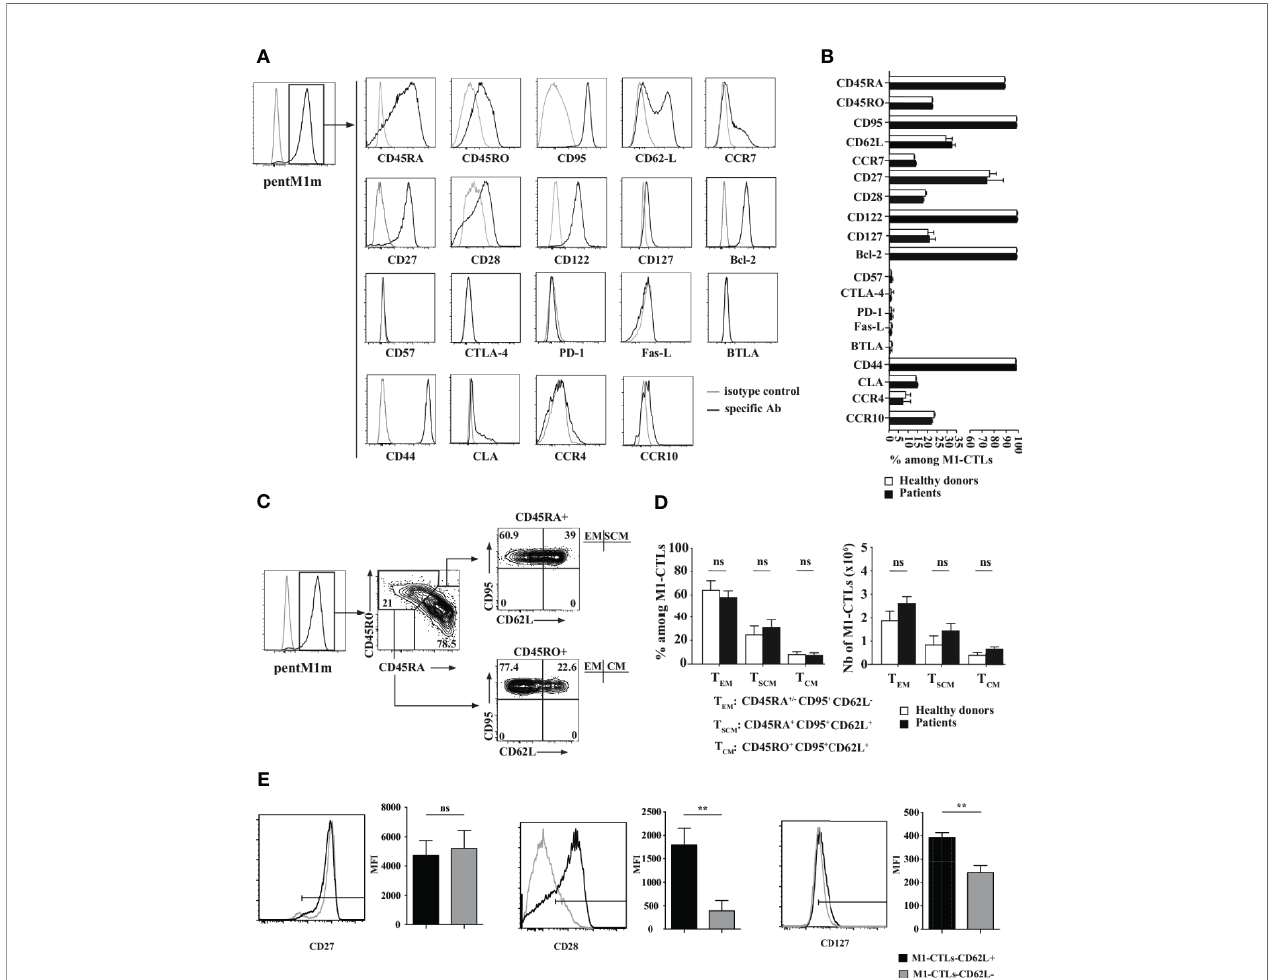
FIGURE 4 | Phenotypic study of pure M1-CTLs at D35 reveals the presence of central memory, effector memory and stem cell-like memory T lymphocytes. (A) Representative examples of expression pro fi les for different families of cell surface markers on PentM1m-stained M1-CTLs obtained at D35. Cell surface markers are distributed as follows (from upper to lower graphs): differentiation state markers, activation state markers, functional inhibition markers and homing markers. Isotype control (grey line) and speci fi c staining (black line) for the respective markers studied are shown. (B) Percentages of M1-CTLs positive for the cell surface markers represented in histograms. (C) M1-CTL CD62L/CD95 fl ow cytometric analyses shown for the CD45RA + (upper right panel) and the CD45RO + (lower right panel) fractions. Three memory T-cell subsets were de fi ned according to the expression of CD45RA, CD45RO, CD95 and CD62L: effector memory (EM), stem cell-like memory (SCM) and central memory (CM) TLs. Relative percentages from a representative experiment are shown for each gate and quadrant. (D) M1-CTL percentages (left panel) and absolute numbers (right panel) of the three de fi ned memory T-cell subsets (T EM , T SCM and T CM ) represented in histograms. (B, D) Histograms were obtained from ten healthy donors (white bars) and six patients (black bars). (E) Comparison of CD27, CD28 and CD127 mean fl uorescence intensity (MFI) staining of CD62L + gated M1-CTLs (black pro fi les and bars) and CD62L - gated M1-CTLs (gray pro fi les and bars). Histograms were obtained from six healthy donors. Data are shown with standard errors of means. Statistical tests (t tests) were performed to compare both groups. Not signi fi cant (ns): p > 0.05, ** p <